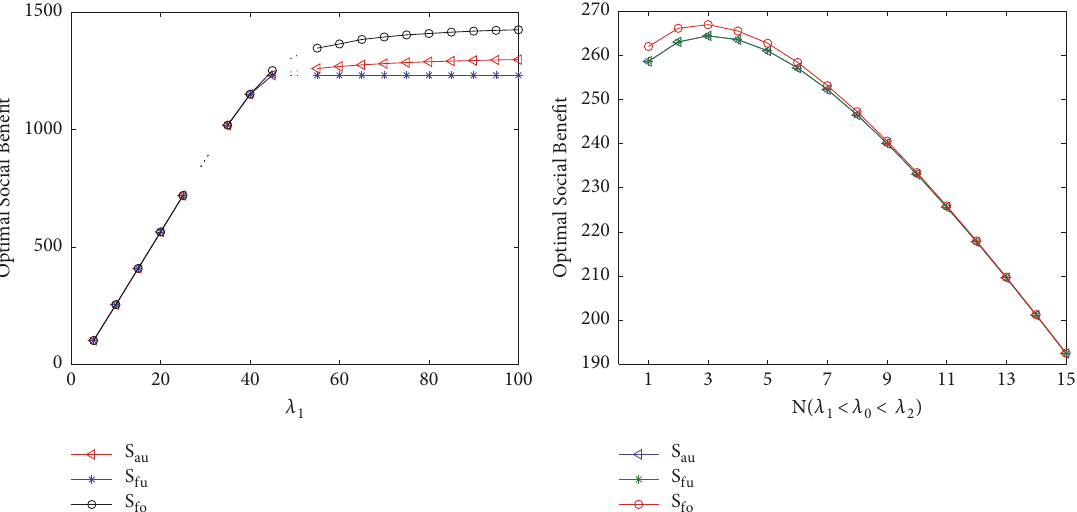
Figure 10: Left: optimal social benefit under three different information levels vs. 𝜆 1 for 𝑅 = 30, 𝐶 1 = 15, 𝐶 2 = 10, 𝜆 0 = 30, 𝜆 2 = 50, 𝑁 = 5. Right: optimal social benefit under three different information levels vs. 𝑁 ( 𝜆 1 < 𝜆 0 < 𝜆 2 ) for 𝑅 = 30, 𝐶 1 = 15, 𝐶 2 = 10, 𝜆 1 = 10, 𝜆 0 = 12, 𝜆 2 =